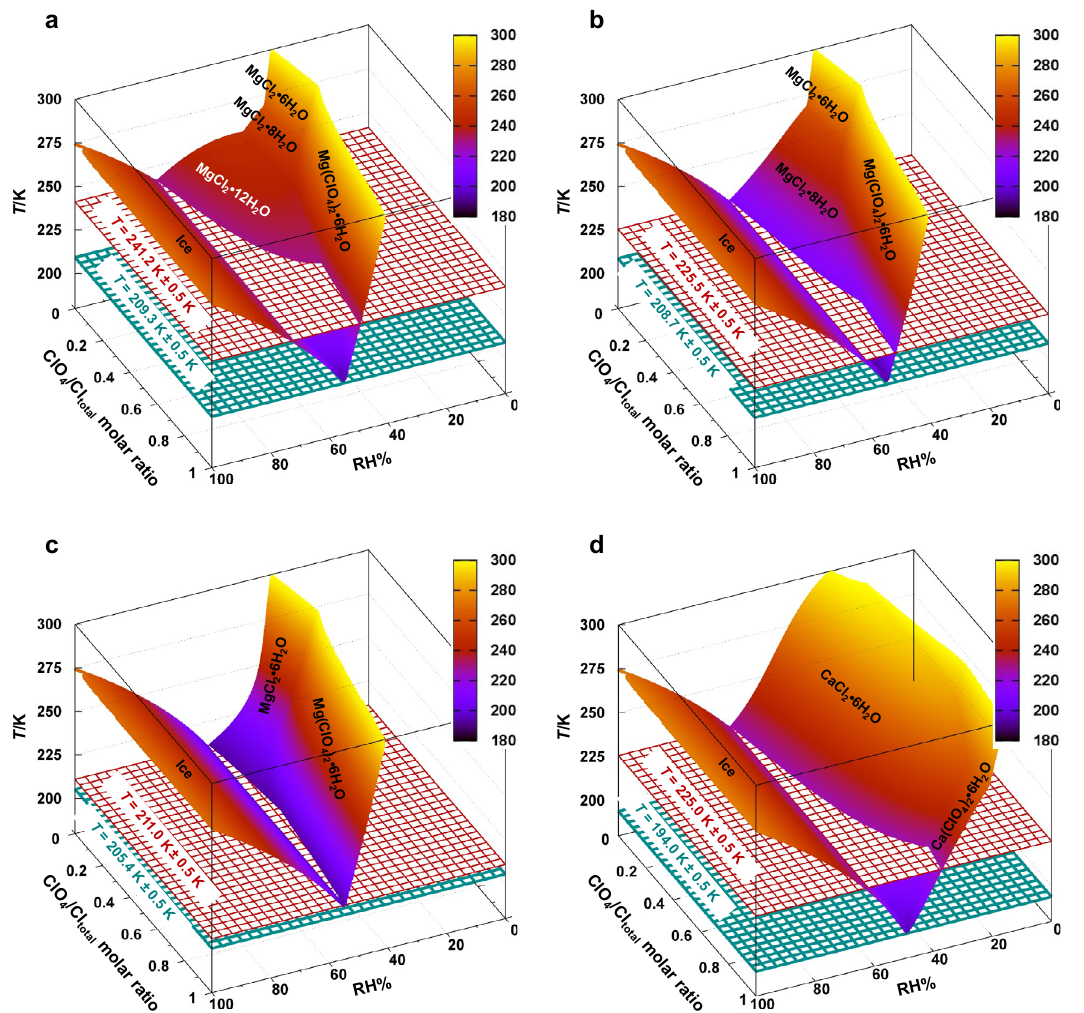
Fig. 1 Deliquescence surfaces of mixed hydrated Mg- and Ca- perchlorate/chloride salt mixtures calculated using thermodynamic models. a – c show the ternary system Mg(ClO 4 ) 2 + MgCl 2 + H 2 O with the lowest eutectic of thermodynamically stable state ( a : Mg(ClO 4 ) 2 (cid:129) 6H 2 O + MgCl 2 (cid:129) 12H 2 O + ice) and metastable state ( b : Mg(ClO 4 ) 2 (cid:129) 6H 2 O + MgCl 2 (cid:129) 8H 2 O + ice; c : Mg(ClO 4 ) 2 (cid:129) 6H 2 O + MgCl 2 (cid:129) 6H 2 O + ice). d shows the ternary system Ca(ClO 4 ) 2 + CaCl 2 + H 2 O under a thermodynamically stable state with the lowest eutectic of Ca(ClO 4 ) 2 (cid:129) 6H 2 O + CaCl 2 (cid:129) 6H 2 O + ice. Colored deliquescence surfaces represented by the legend are the interfaces for the phase transition of ternary ClO 4 − -Cl − -H 2 O systems in each salt mixture. The dark cyan planes and dark red planes are the lower- and upper- T boundaries between which ClO 4 − /Cl − fractionation can occur. The lower- T boundary plane intercepts the minima of the ternary deliquescence surfaces, below which no deliquescence would occur. The upper- T boundary plane intercepts the minima of the binary deliquescence surfaces of the chloride- water system (i.e., ClO 4 − /Cl total molar ratio = 0), above which both ClO 4 − and Cl − can be completely dissolved and no ClO 4 − /Cl − fractionation would